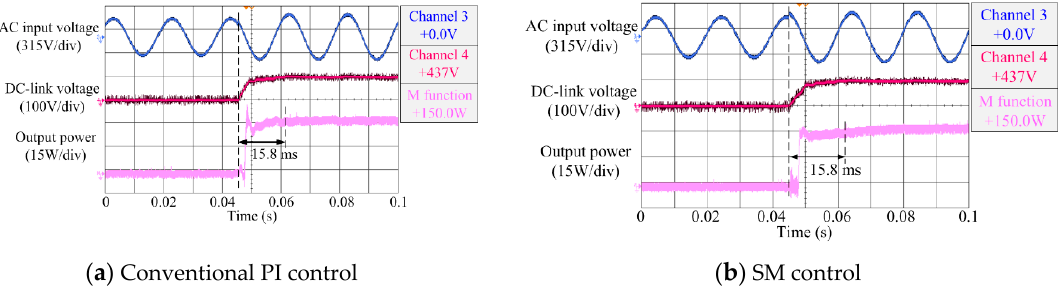
Figure 3. The experimental waveforms of the DC grid voltage and the output power of the power conversion system for input voltage changing from 180 to 220 V.